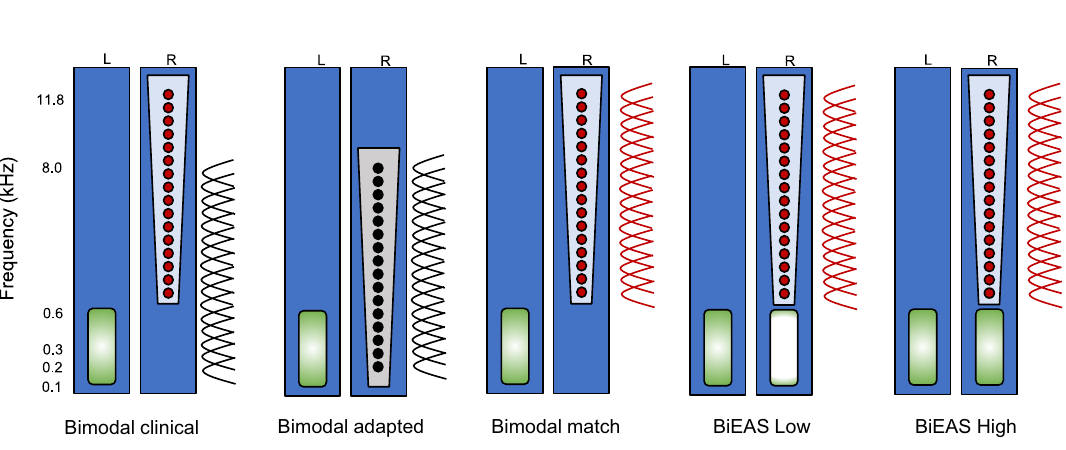
Figure 3. Illustration of the speech processing conditions for the left (L) and right ears (R). The green areas represent the range of simulated residual acoustic hearing. The circles represent the simulated electrode locations (output frequency range). The red circles represent a typical electrode insertion, and the black circles represent a deep insertion. The analysis bands (input frequency range) are shown at the right of each processing condition. The black analysis bands represent the clinical acoustic-to-electric frequency allocation and the red analysis bands represent a tonotopically matched allocation relative to a typical electrode insertion